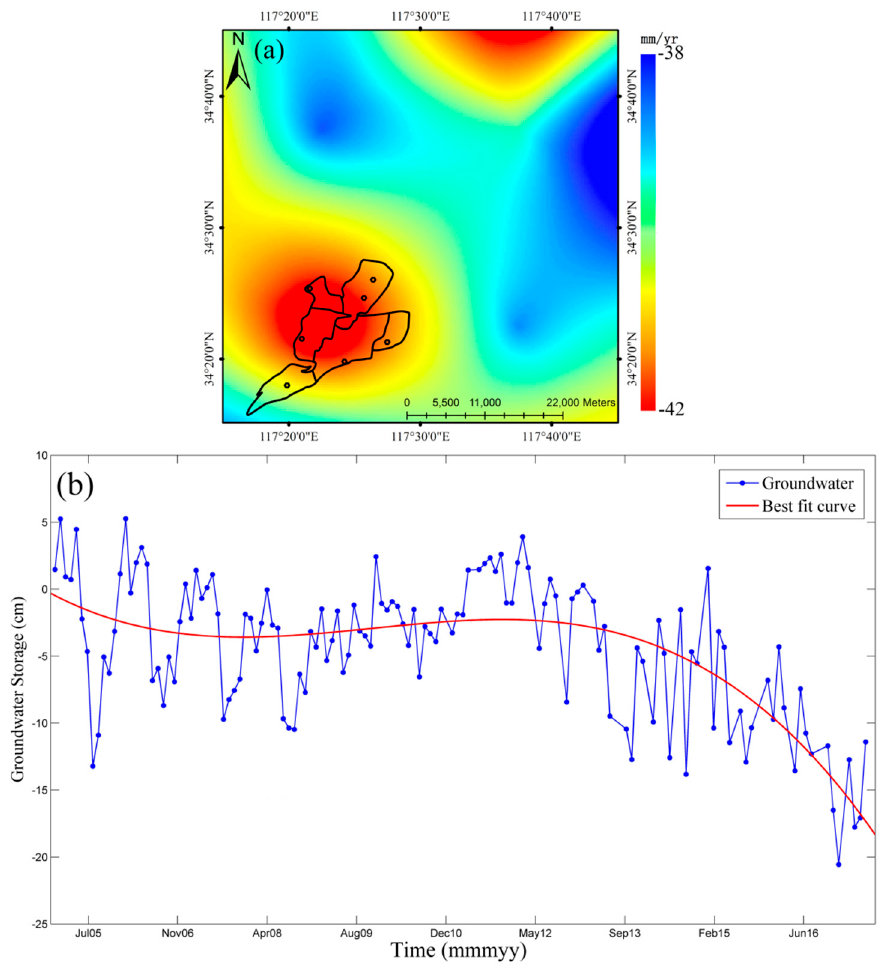
Figure 6. ( a ) Spatial pattern of the groundwater storage change trend obtained by GRACE and GLDAS. The black line represents the abandoned coal mine. ( b ) Time series variation in the groundwater storage of the research area.